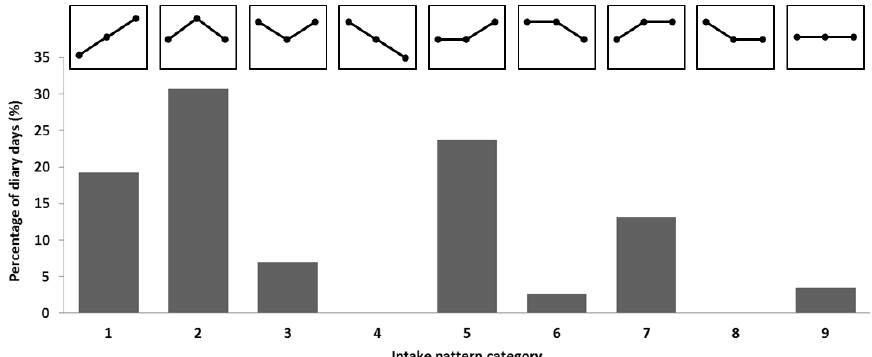
Figure 1. Percentage of days in each category of protein intake pattern. Patterns are depicted above each bar, showing the relationship between periods 1 (05:00–11:00), 2 (11:00–16:00), and 3 (16:00–23:59) in each category.